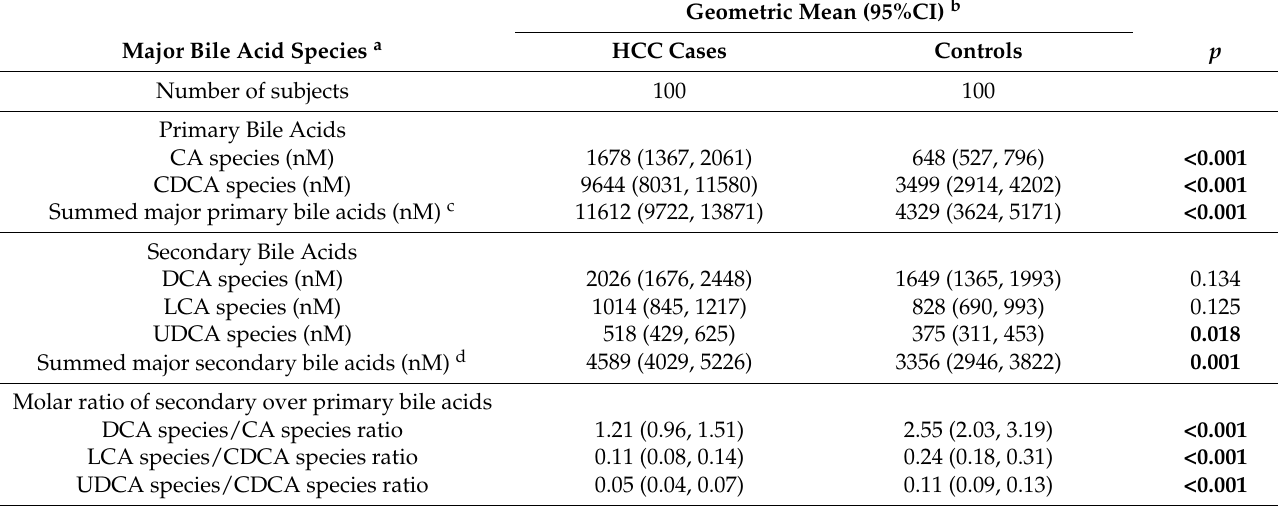
Table 2. Geometric means of major primary and secondary bile acids and molar ratios of the secondary over primary bile acids in hepatocellular carcinoma (HCC) cases and controls, The Singapore Chinese Health Study.